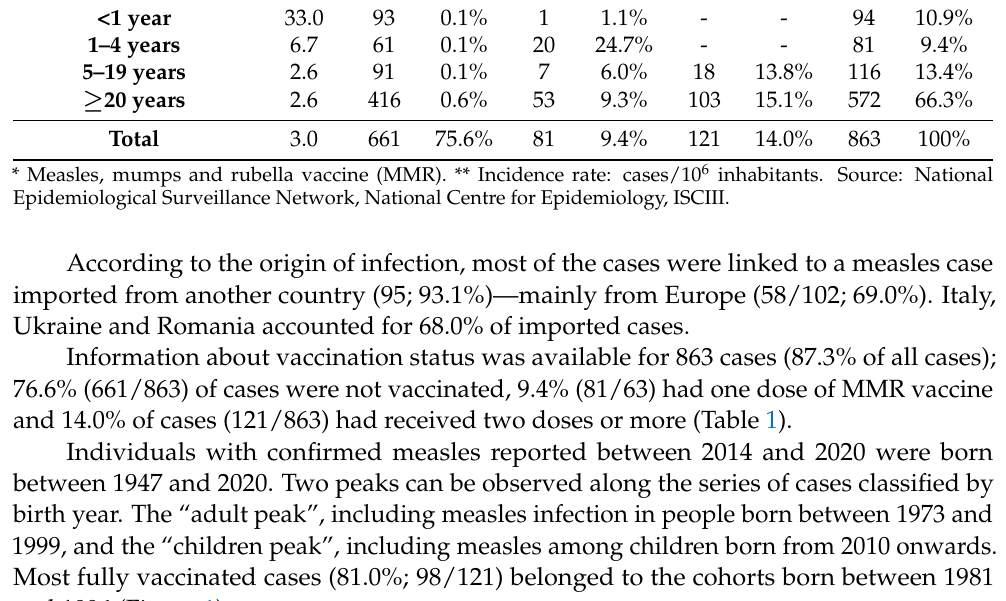
Table 1. Measles cases with known vaccination status by age group and number of MMR * vaccines. Spain, 2014–2020.